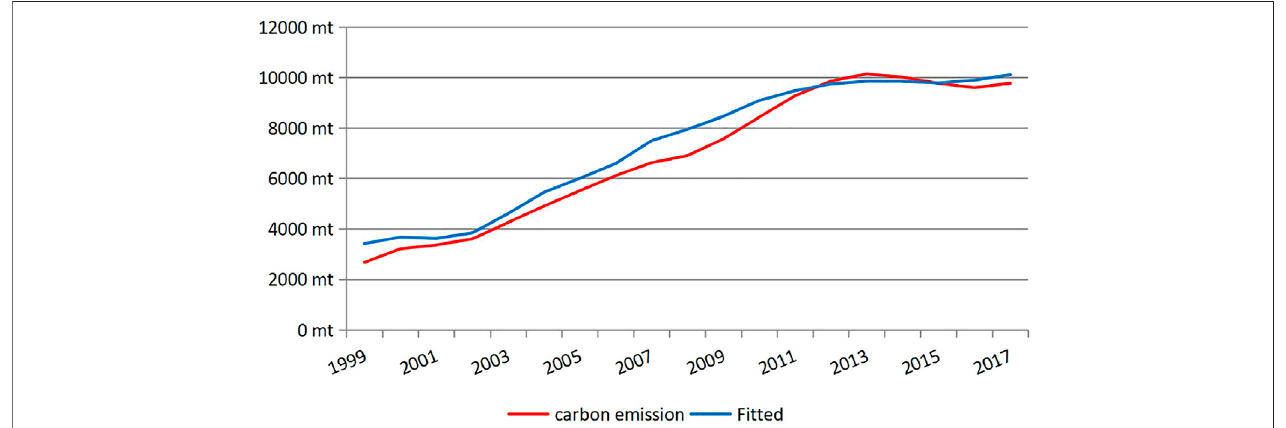
FIGURE 2 | The fi tted values and the real data of carbon emissions of China from 1999 to 2017.